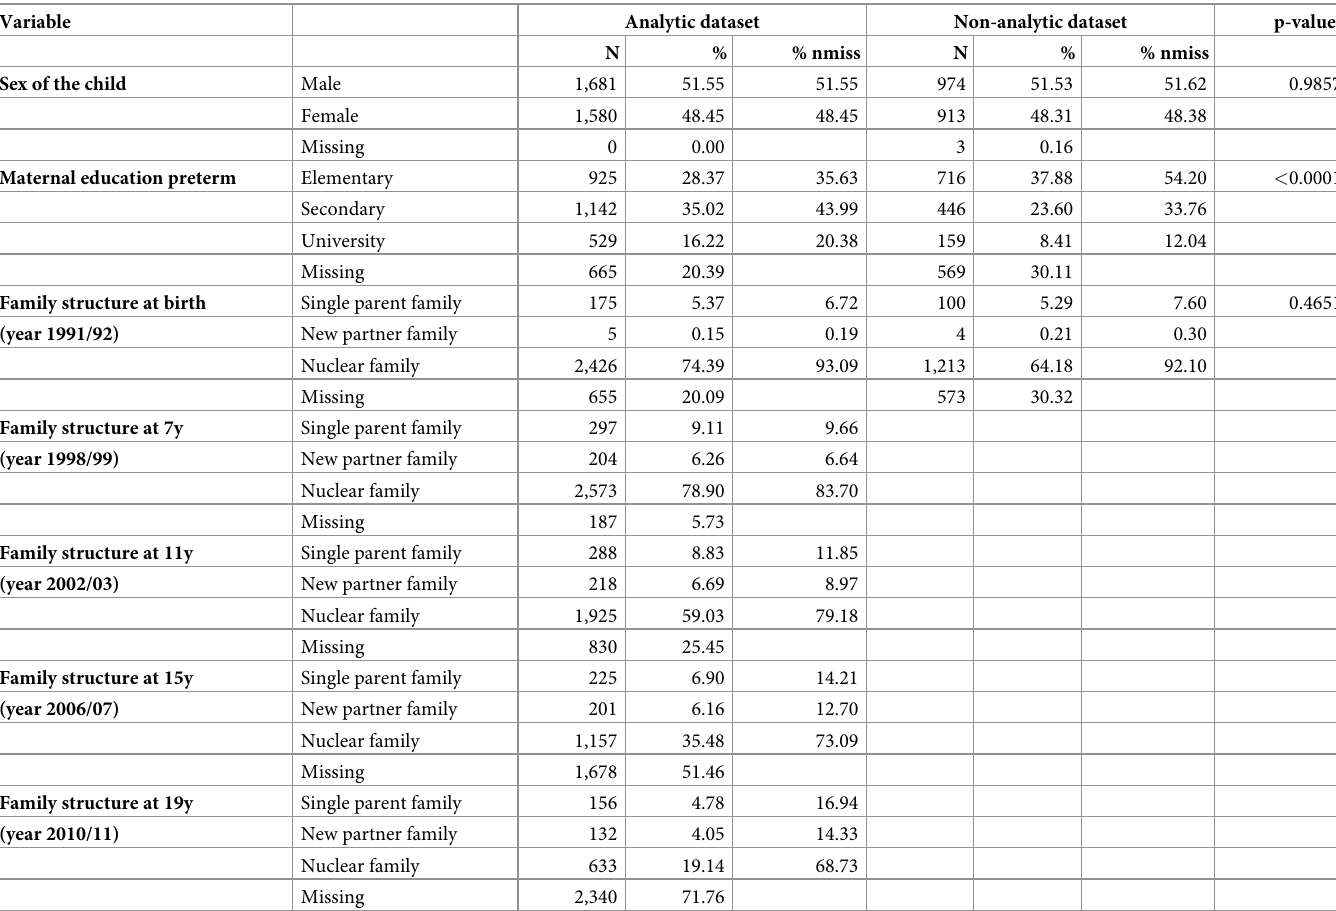
Table 1. Overview of sample characteristics for individual time-points and variables in the analytic and non-analytic dataset.